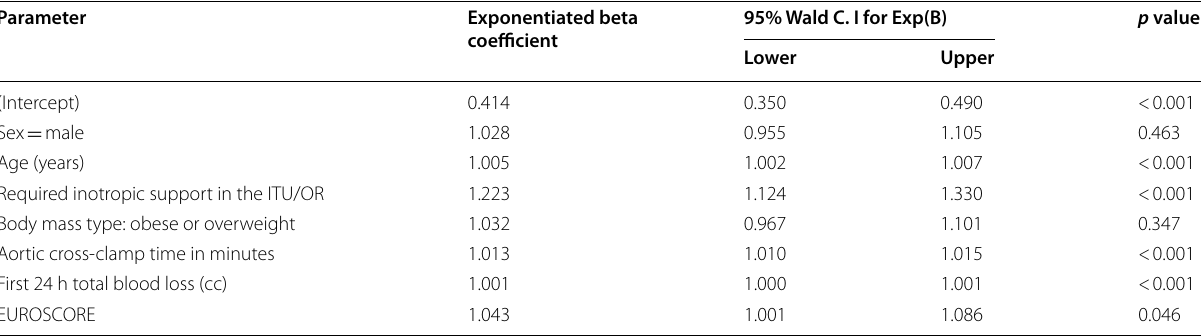
Dependent variable: ICU length of stay days. Estimating method a risk rate or like an odds